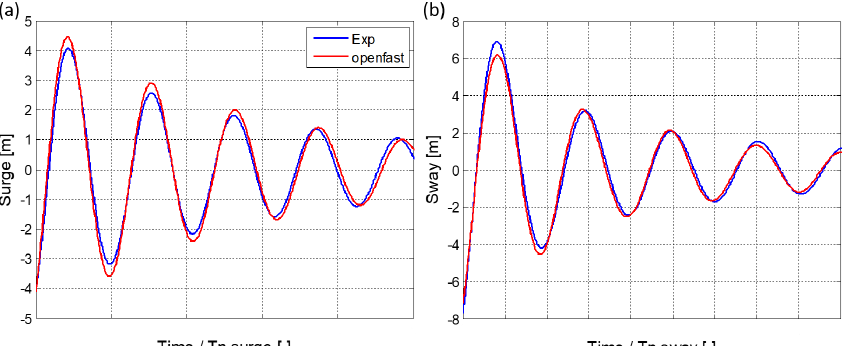
Figure 4. Free-decay results for (a) surge and (b) sway.